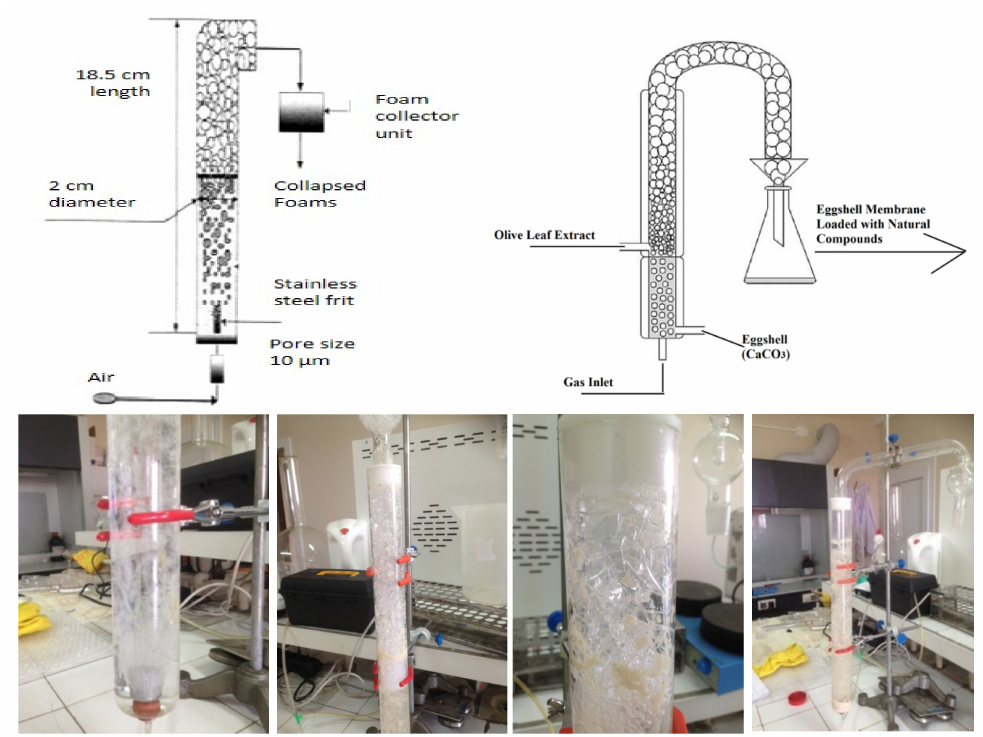
Figure 1. Experimental set-up used for the preparation of OLE (olive leaf extract)-loaded eggshell